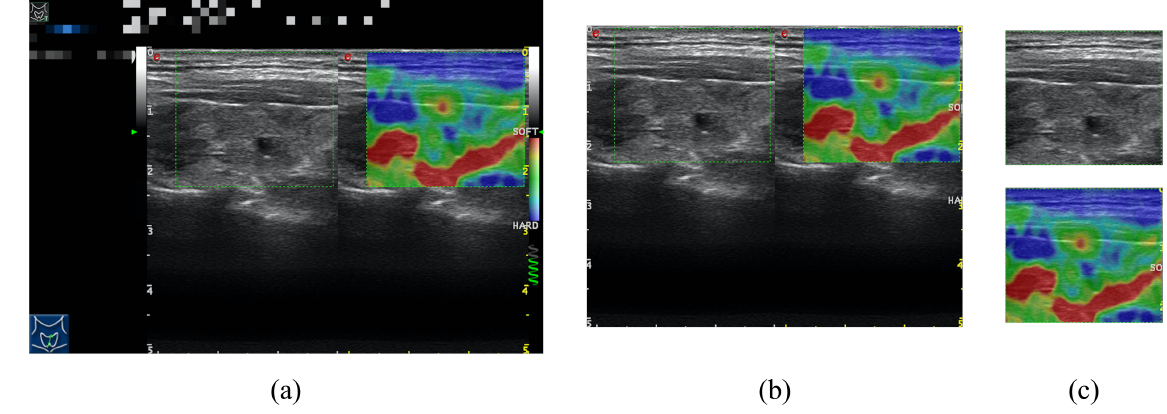
Figure 1. Example image of three steps in data preprocessing. ( a ) Original images obtained from same ultrasound equipment, which have same dimensions of 800 × 555. ( b ) First cropped image using fixed positions according to equipment information. ( c ) Final cropped ultrasound image-elastography image pair obtained by color gradient cropping algorithm.